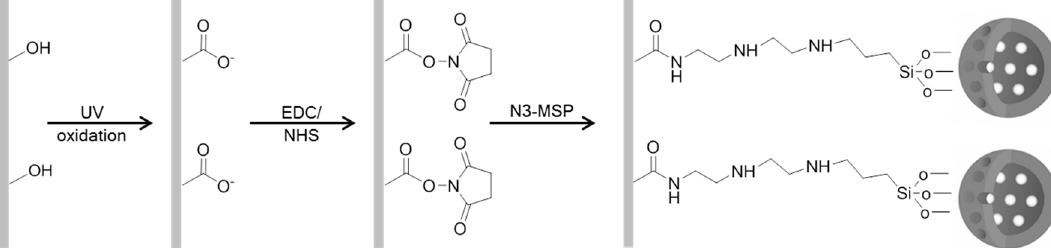
Figure 1. Scheme of the functionalization process: surface modification of ethylene vinyl alcohol (EVOH) and the subsequent carbodiimide-mediated anchoring of N -(3-trimethoxysilylpropyl)diethylenetriamine (N3)-functionalized mesoporous silica particles (MSPs).